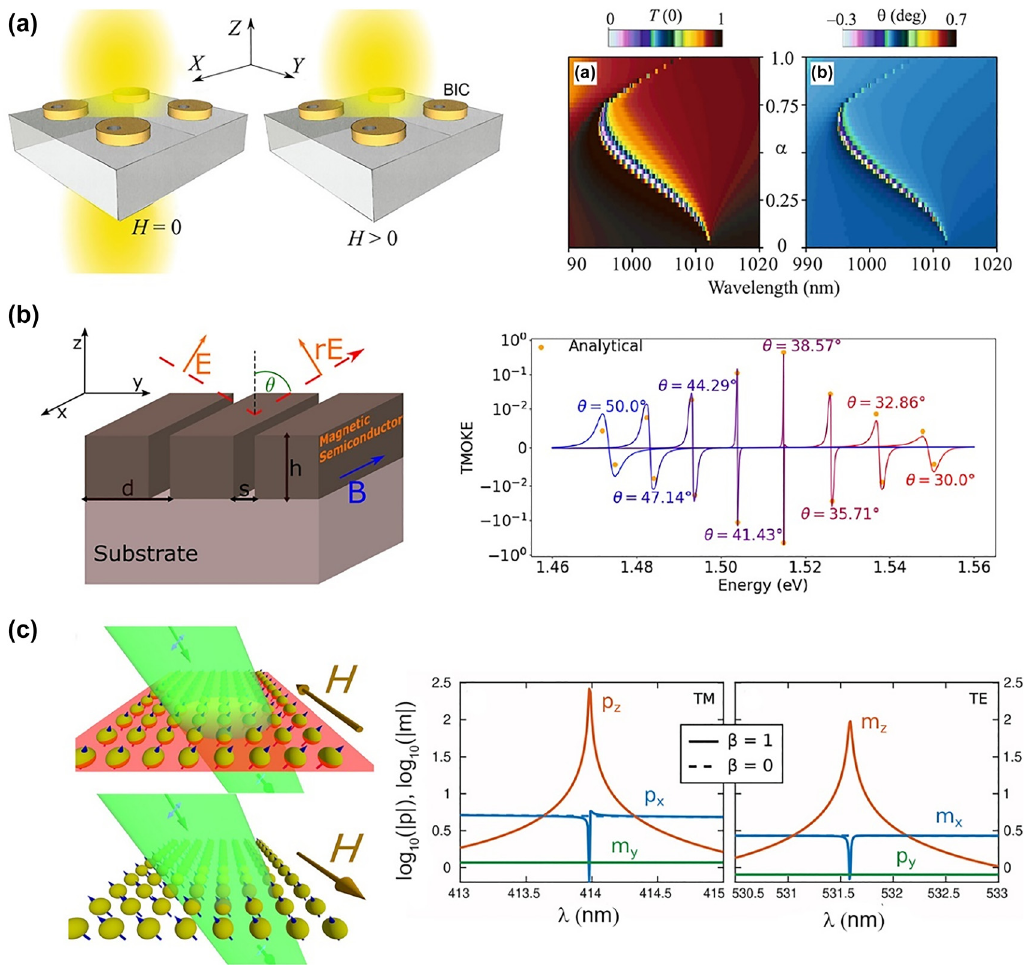
Figure 8: All-dielectric MO resonators with BIC resonance modes. (a)Structure,transmittance,andFRinall-dielectricBIGnanodiskswithairholesdisplacedawayfromthediskcenter.Therightfigurepresents the transmission and FR spectra as function of the asymmetry factor α . (b) Structure and TMOKE in a magnetic semiconductor Cd x Mn 1 − x Te grating that supports BIC modes. The right fi gure presents the TMOKE spectra for different incident angles. (c) Tuning of BIC using applied magnetic fi eldinall-dielectricMOstructure.Themiddle fi gurepresentstheout-of-planeelectricdipole p z andin-planecontributions p x , m y for TM polarization with ( β = 1, solid curves), and without ( β = 0, dash curves) MO activity. The right fi gure presents the out-of-plane magnetic dipole m z and in-plane contributions m x , p y for TE polarization. The panels of this fi gure contain pictures adapted from References [121 –